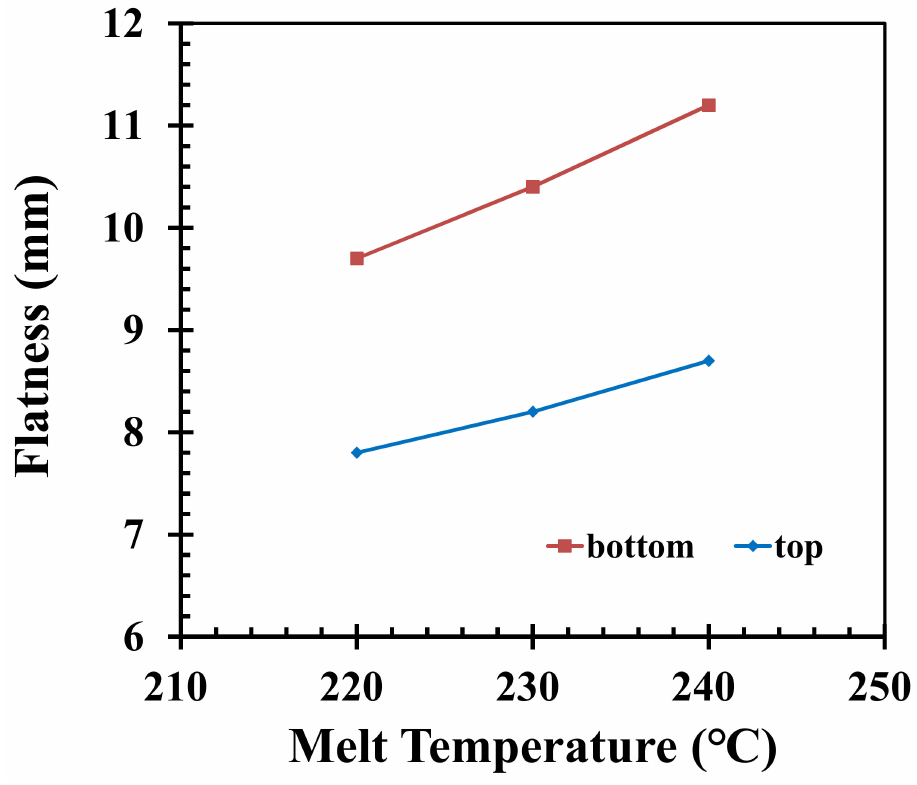
Figure 5. Influence on flatness values by adjusting the melt temperature. The cooling water temperatures are set as 20, 30, 40, 50, 60, and 70 ◦ C to analyze how the flatness of the product is affected. It can be seen in Figure 6 that when the temperature of the cooling water increases, the flatness values have a clear downward trend, while decreasing the temperature of the cooling water leads to higher flatness values. By increasing the temperature of the cooling water, the freeze time is lengthened, which leads to more effective packing. Due to the lower and upper limits of the cooling water temperature, which are 20 ◦ C and 70 ◦ C, respectively, the change in flatness values of the top and bottom of the pallet are 55.5% and 52.3%, respectively. The cooling time is 33, 43, 53, 63, and 73 s, while the other injection parameters are fixed according to Table 1. Through simulation, the flatness of the pallet is shown in Figure 7. As can be seen, when shortening the cooling time, the average temperature of the pallet is decreased while the pallet is ejected from the mold; therefore, the temperature difference between the highest and lowest point on the same surface is increased. This causes the flatness values of the top and bottom of the pallet to be increased. An increase in cooling time results in a temperature difference between the exterior and interior of the pallet, which leads to a higher rate of deformation in the z-axis. The warping of the product also increases. However, with a shorter cooling time, lower flatness values would